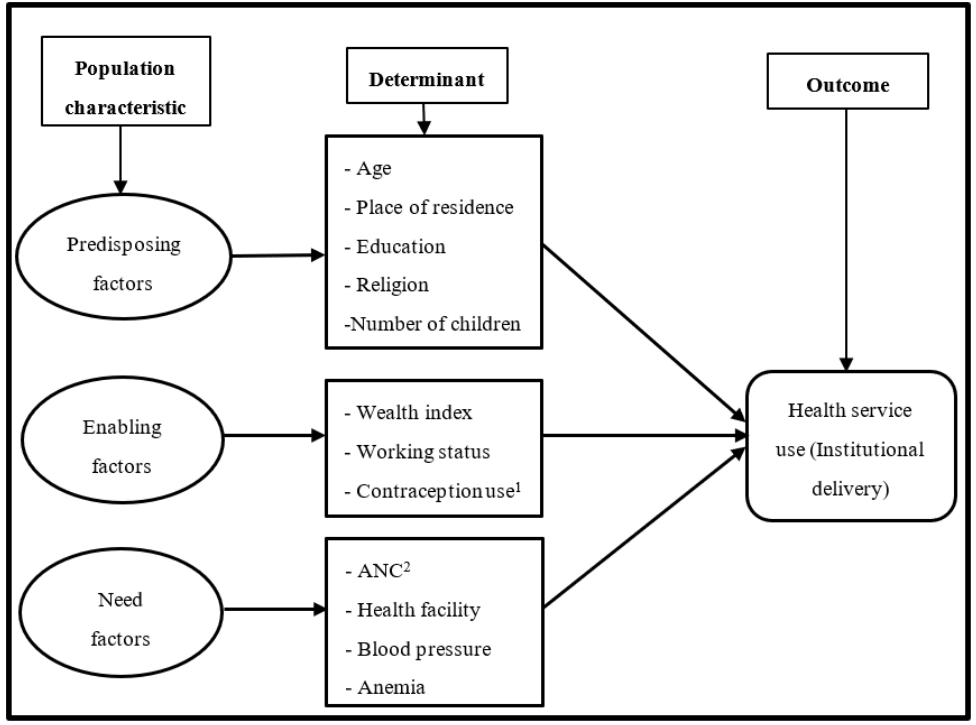
Figure 1. The conceptual framework for health services utilization is modified from Andersen’s behavioral model. 1 Contraception use decision; 2 number of antenatal care visits during pregnancy.